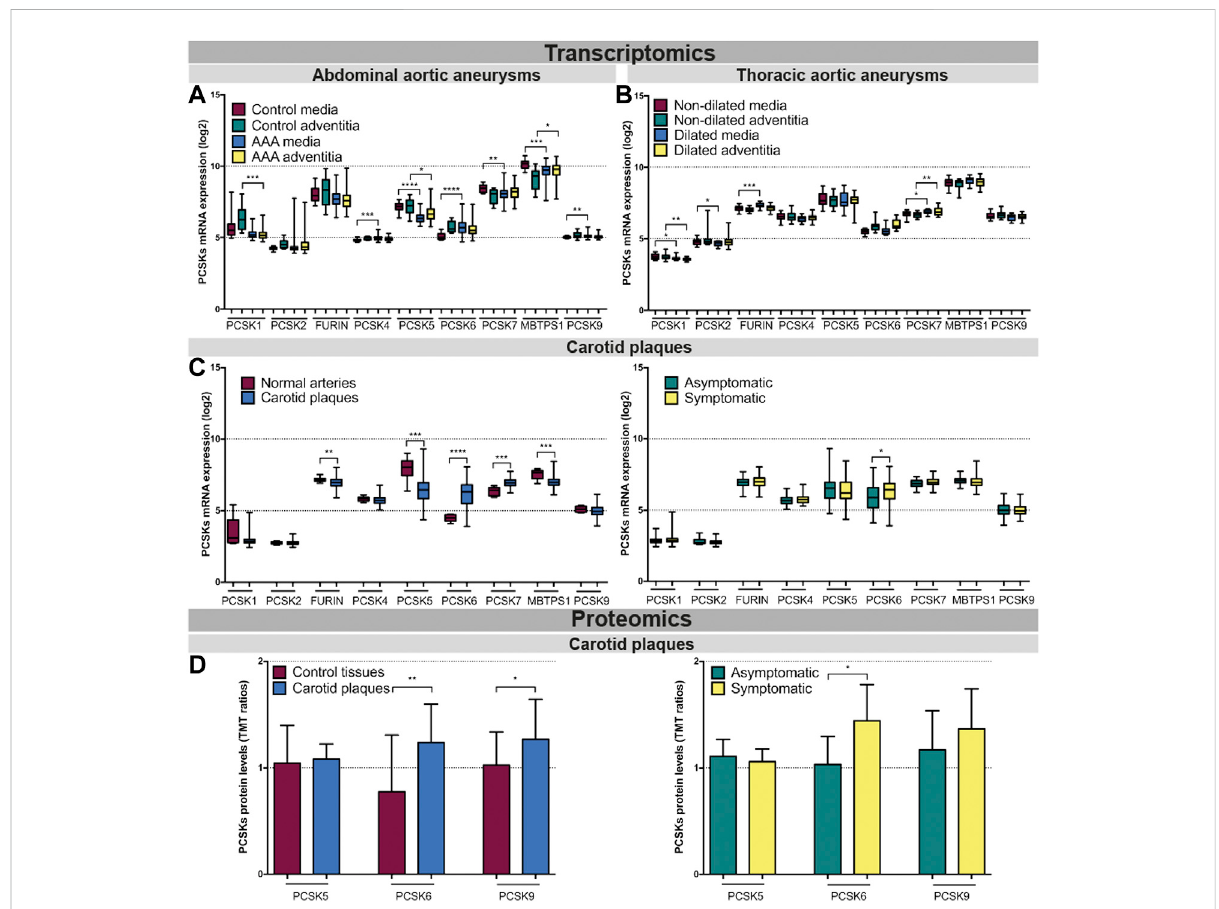
FIGURE 3 Transcriptomic and proteomic analyses of the PCSK family in human vascular tissues. PCSK mRNA expression in abdominal aortic aneurysm tissues comparing AAA media (n = 76) with control media (n = 13) and AAA adventitia (n = 76) with control adventitia (n = 13) (A) . PCSKs mRNA expression in thoracic aortic aneurysm tissues from TAV patients comparing dilated media (n = 22) with non-dilated media (n = 24) and dilated adventitia (n = 22) with non-dilated adventitia (n = 19) (B) . mRNA levels of the different members of the PCSK family in atherosclerotic plaque tissues comparing carotid plaques (n = 127) with normal arteries (n = 10) and plaques from symptomatic patients (n = 87) with those from asymptomaticones (n = 40) (C) . Proteomic analysis ofthe PCSK family members in atherosclerosiscomparing plaques vs. matched adjacentarterial control tissues as well as plaques from symptomatic vs. asymptomatic patients (D) . Data is shown as mean with SD, p -values were calculated using unpaired t -test with Welch ’ s correction. * p < 0.05, ** p < 0.01, *** p < 0.001, **** p < 0.0001. Abdominal aortic aneurysm (AAA), tricuspid aortic valve